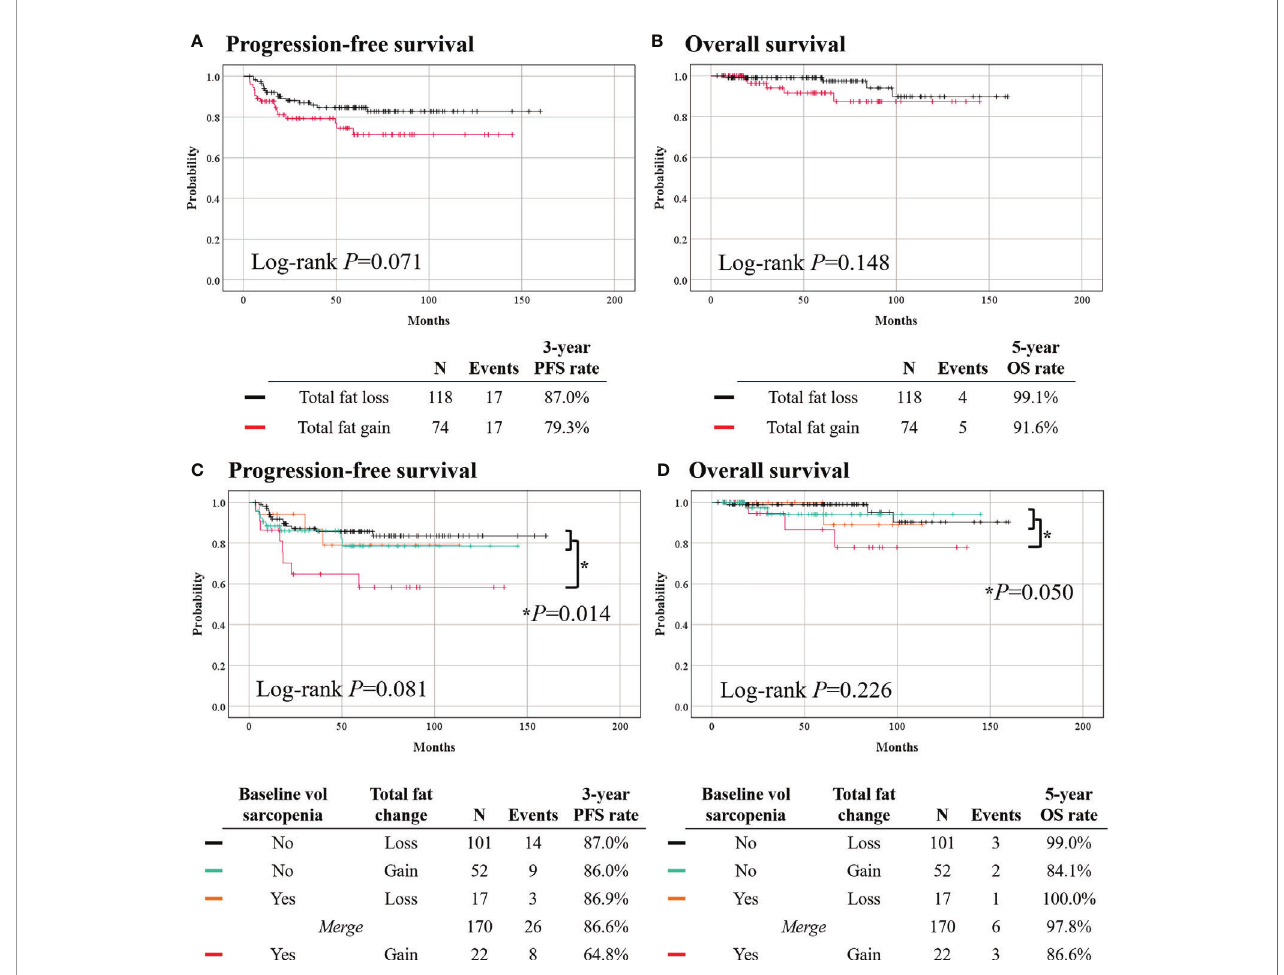
FIGURE 3 | Comparisons of survival outcomes according to changes in total fat volume (top) and combinations of baseline volumetric sarcopenia and waist total fat change (bottom). (A, C) Progression-free survival. (B, D) Overall